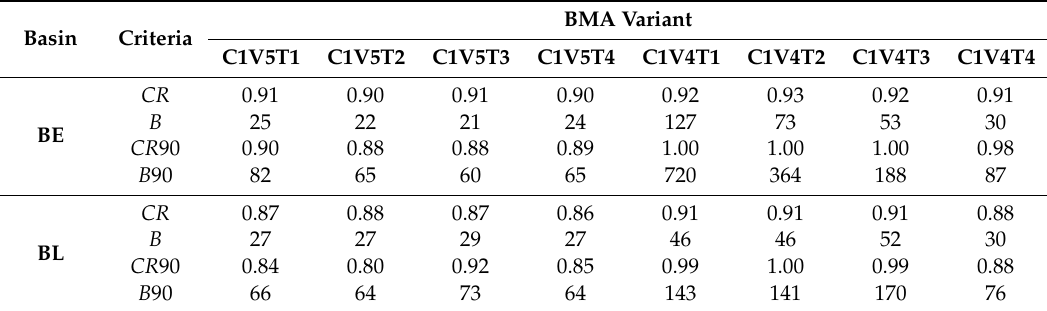
Table5. Probabilisticevaluationcriteriaofdi ff erentBMAvariantsbasedondi ff erentdatatransformation methods for both watersheds in the validation period Basin